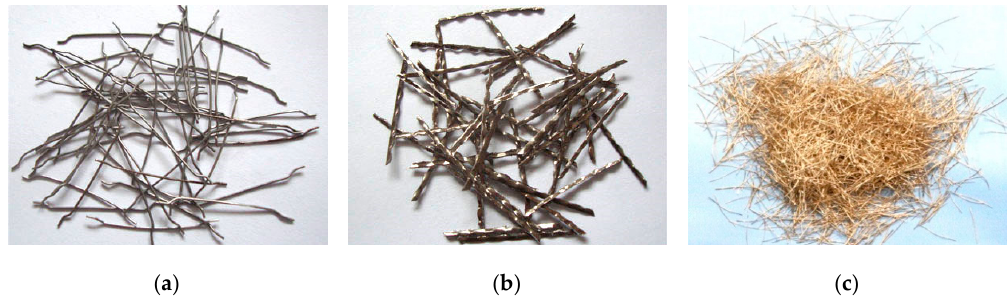
Figure 2. Appearance of the steel fibers: ( a ) hooked-end steel fiber (HESF); ( b ) undulated steel fiber (USF); ( c ) copper-plated steel fiber